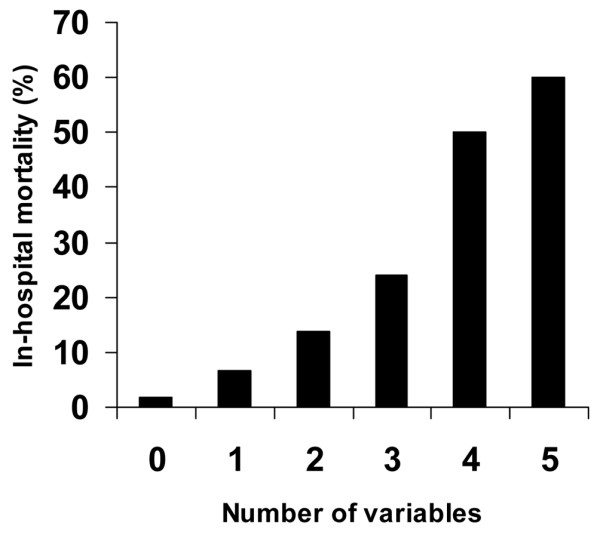
Mortality (%) according to the five variables (X axis) associated with death in the multivariate analysis.